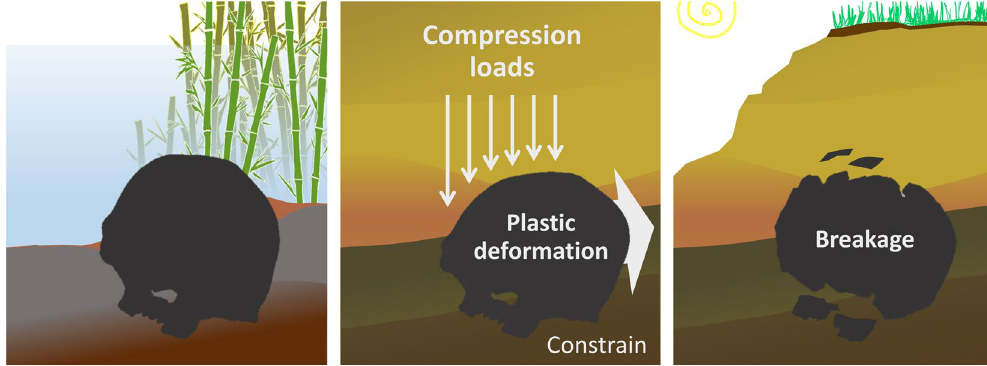
Figure 2. Hypothesized original position of the Ceprano calvarium within the sediments, and subsequent phases of the diagenetic process; plastic deformation occurred before the fossilization of the cranium, with eventual breakage and loss of bony materials on the left and longitudinal fractures on the